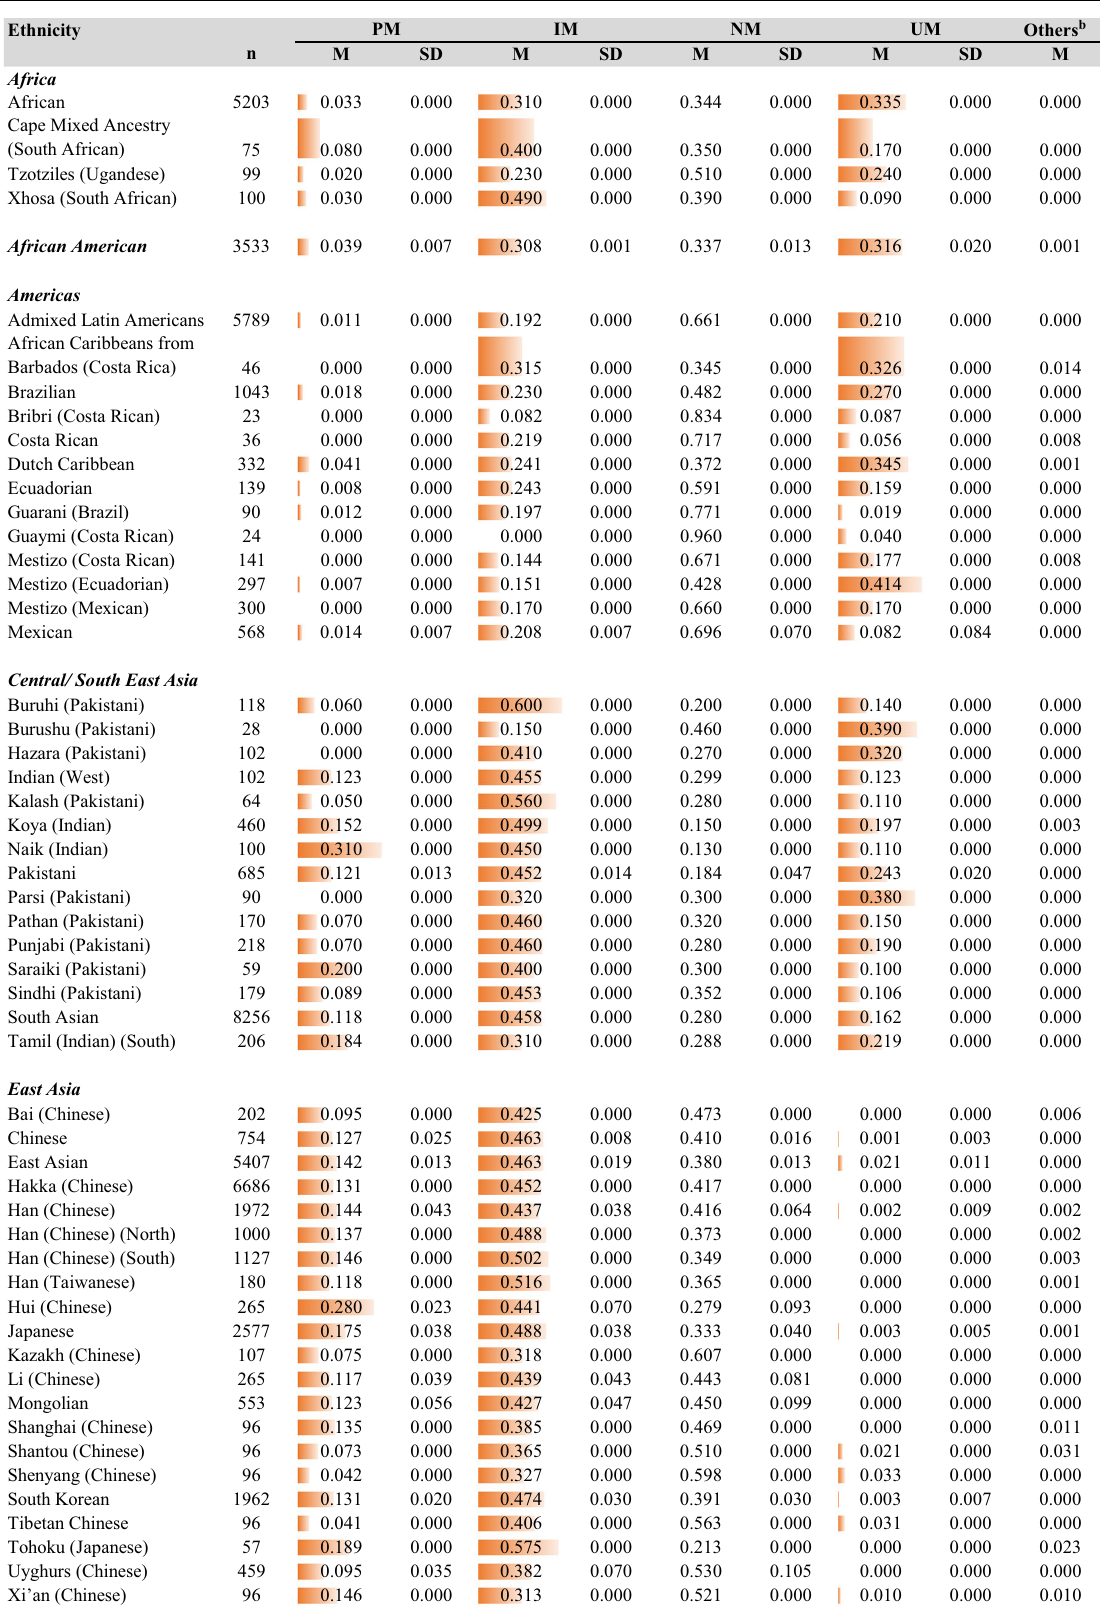
Table 4 Mean frequencies of CYP2C19 predicted phenotypes per ethnicity a .